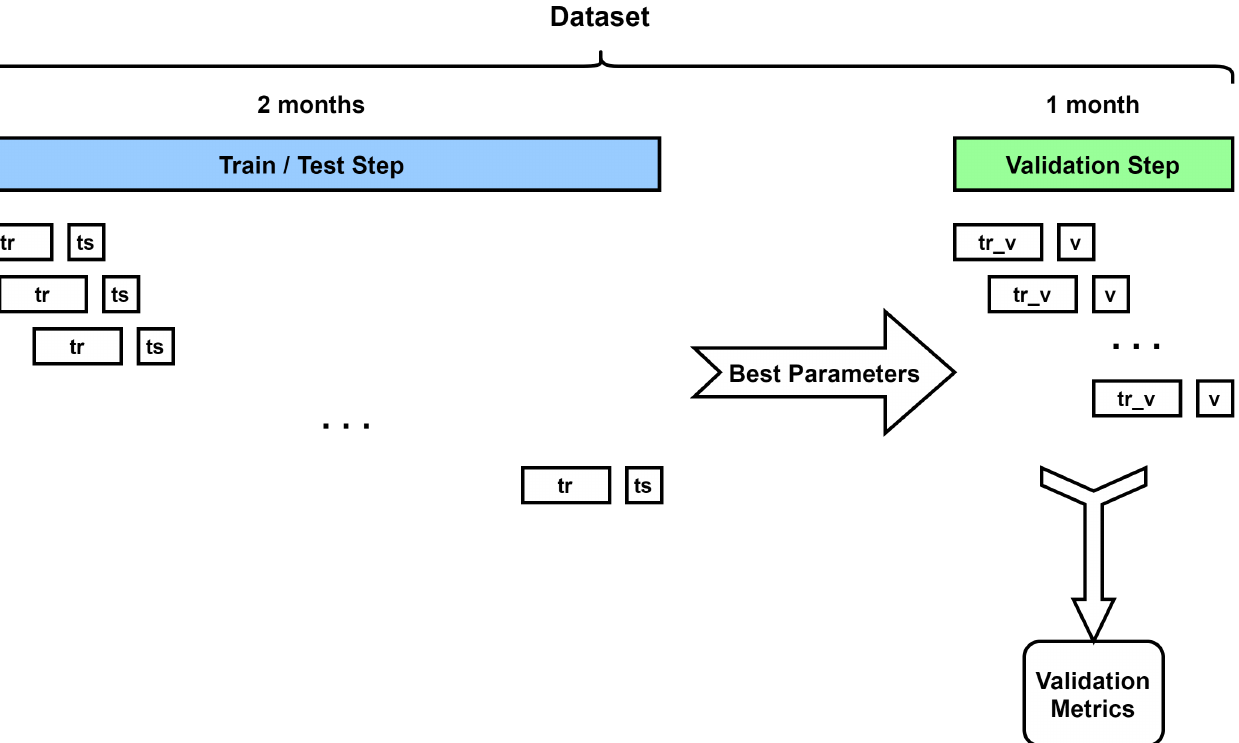
Figure 2. Scheme followed in our proposal using the MIMO strategy. To improve the reliability of the results, the dataset is divided in two subsets: The first subset will be used to train and search for the best hyperparameters of the model, the input-output pairs are formed by training and testing sample time points named tr and ts . The second subset will be used to validate the model on a new dataset once the best hyperparameters are identified, in order to avoid overfitting. In this case the input-output pairs are formed by tr _ v and v .